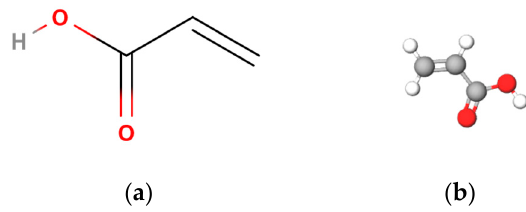
Figure 8. 2D ( a ) and 3D ( b ) chemical structure of acrylic acid (CH 2